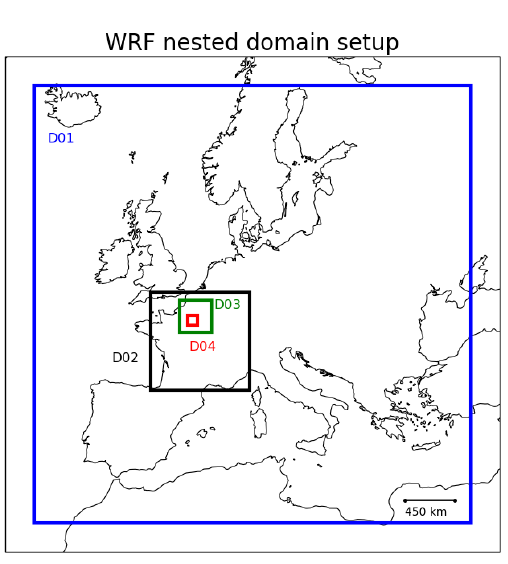
Figure 3. Simulated domains using WRF to calculate meteorologi- cal data: Europe (D01, with a spatial resolution of 45km × 45km), France (D02, with a spatial resolution of 9km × 9km), the Île-de- France region (D03, with a spatial resolution of 3km × 3km) and Paris (D04, with a spatial resolution of 1km ×